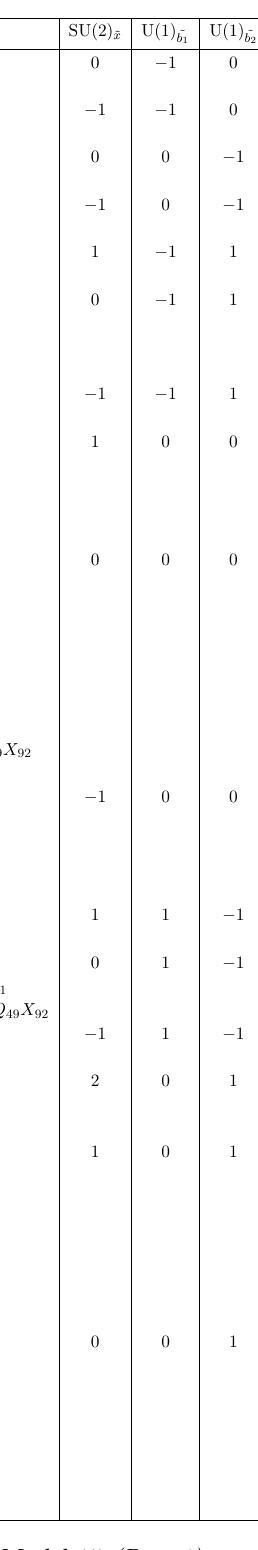
Table 61 . The generators in terms of bifundamental chiral fields for Model 15 (Part 1)